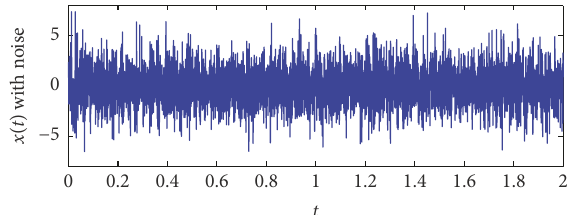
Figure 5: Estimated instantaneous frequency of the simulated gear vibration signal.